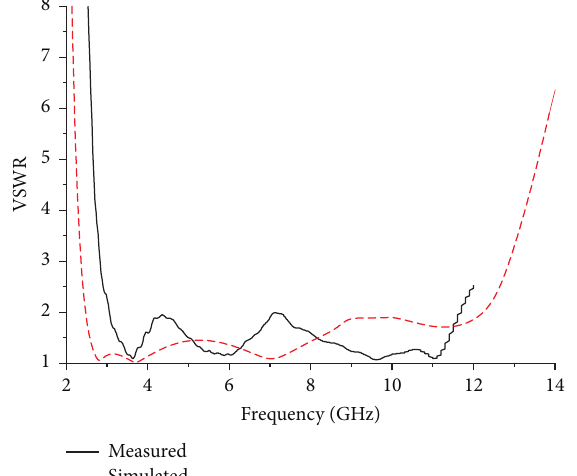
Figure 8: Simulated and measured VSWR.